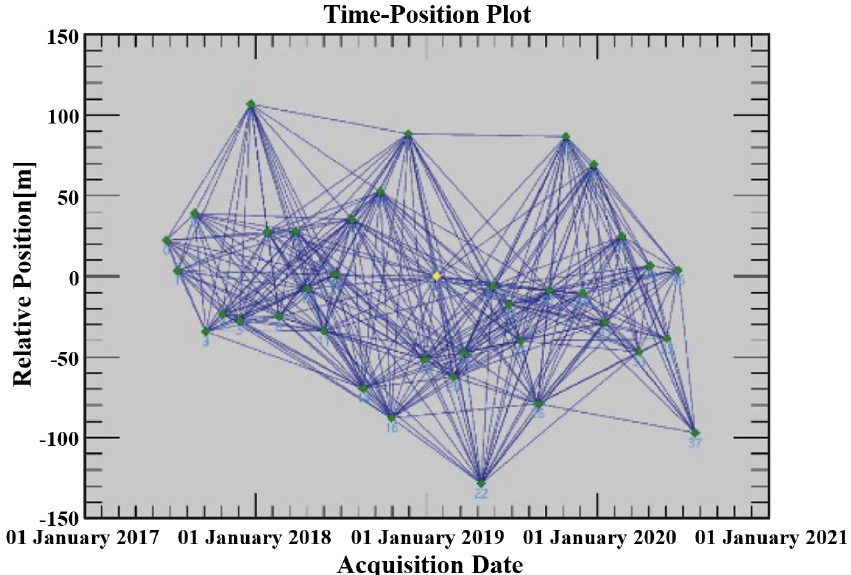
Figure 5. Spatial and temporal baseline distribution of the SBAS-InSAR technique.